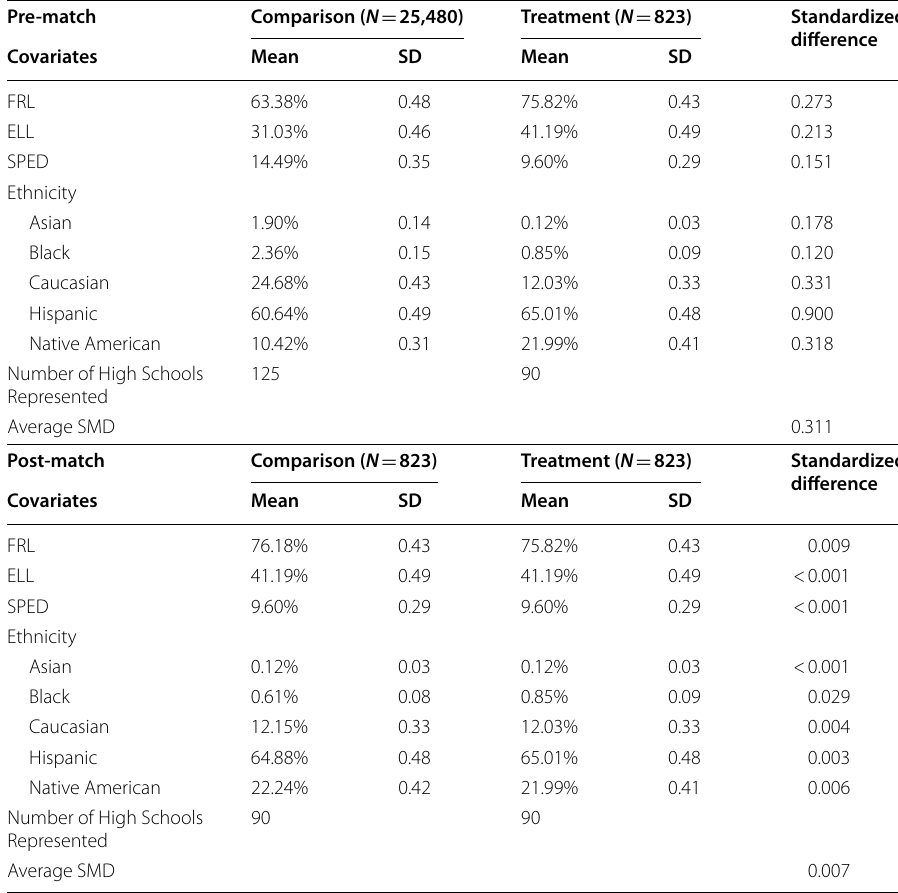
Table 1 Pre/post-match balance results for analysis of graduation